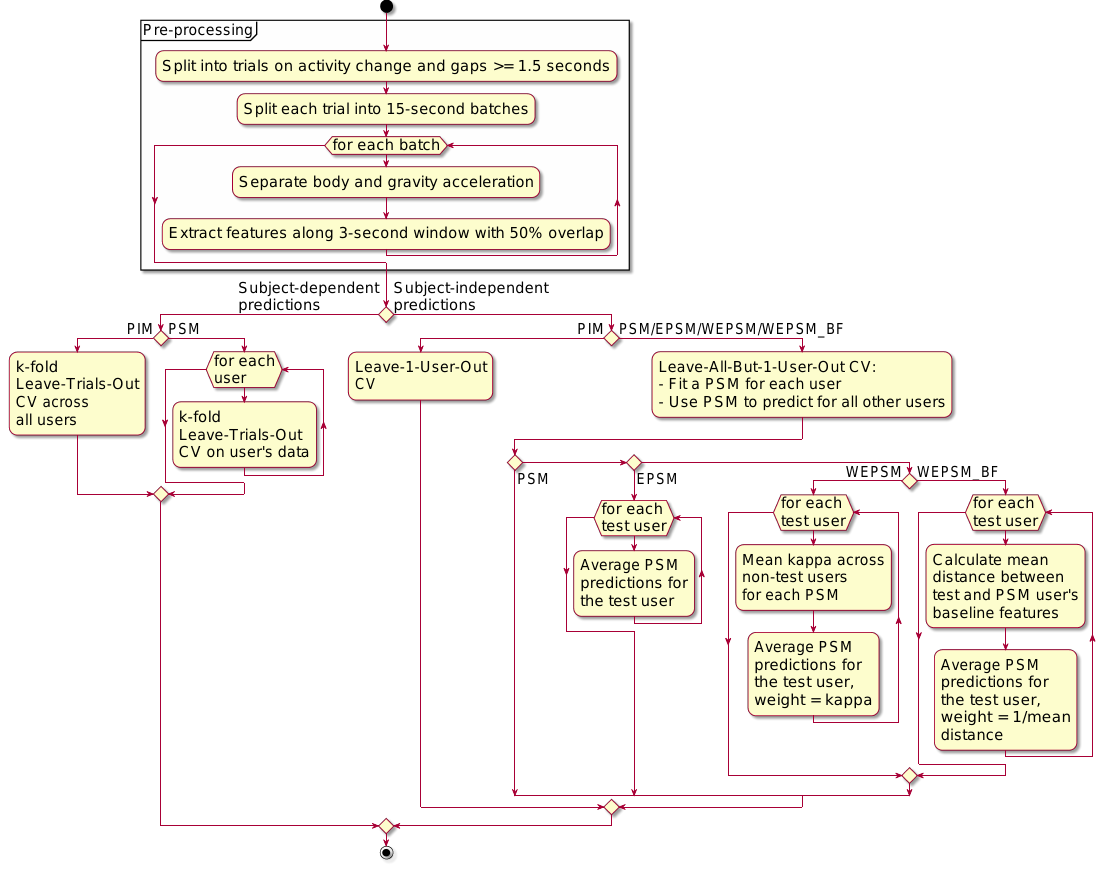
Figure 2. Graphical summary of the experiment. Each dataset is pre-processed once, and then used to obtain the subject-dependent and subject-independent predictions with each learning algorithm and personalisation–generalisation approach (person-independent models (PIMs), person-specific models (PSMs), etc.). Note that an ensemble of PSMs is identical to a PSM in the case of subject-dependent predictions (i.e., for known